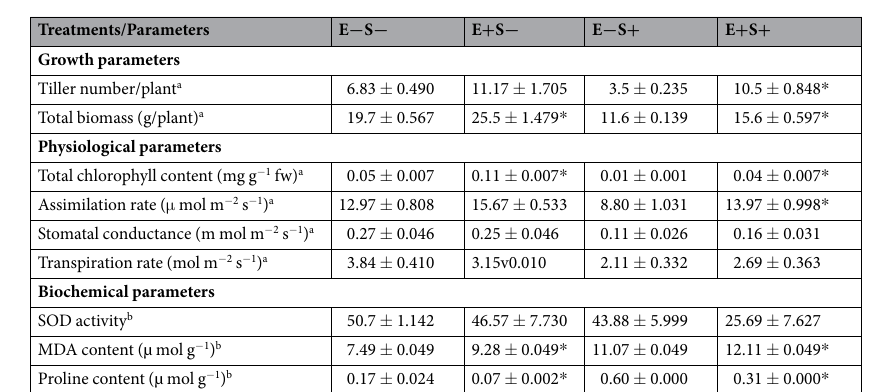
Figure 2. ( A ) Root and shoot growth of 10 day old IR-64 seedlings under different treatments (E − S − ; E + S − ; E − S + ; E + S + where E + /E − : Presence/absence of Fusarium sp . and S + /S − : Presence/absence of salinity stress (150 mM NaCl). ( B ) Phenotypic growth of 50 day old IR-64 plants as influenced by endophyte colonization under control (left) and under 4 ds/m stress (right). ( C ) Root and shoot growth of 50 day old IR-64 plants subjected to different treatments (E − S − ; E + S − ; E − S + ; E + S + where E + /E − : Presence/absence of Fusarium sp . and S + /S − : Presence/absence of salinity stress (4 ds/m). Line on bars indicates SEm ( ± ). One-way ANOVA was done for root and shoot separately. Means with dissimilar letters are significant at P < 0.05 (Tukey).